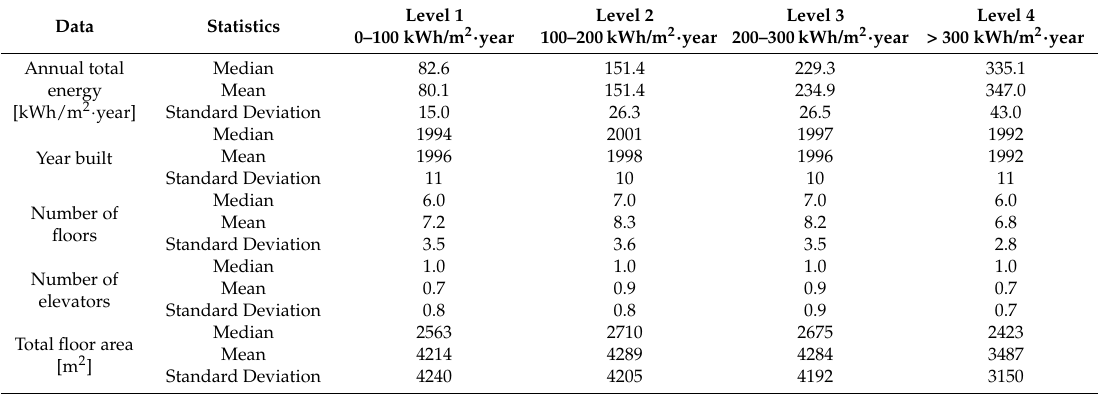
Table 4. Descriptive statistics of the data on annual total building energy with respect to building characteristics in Seoul,